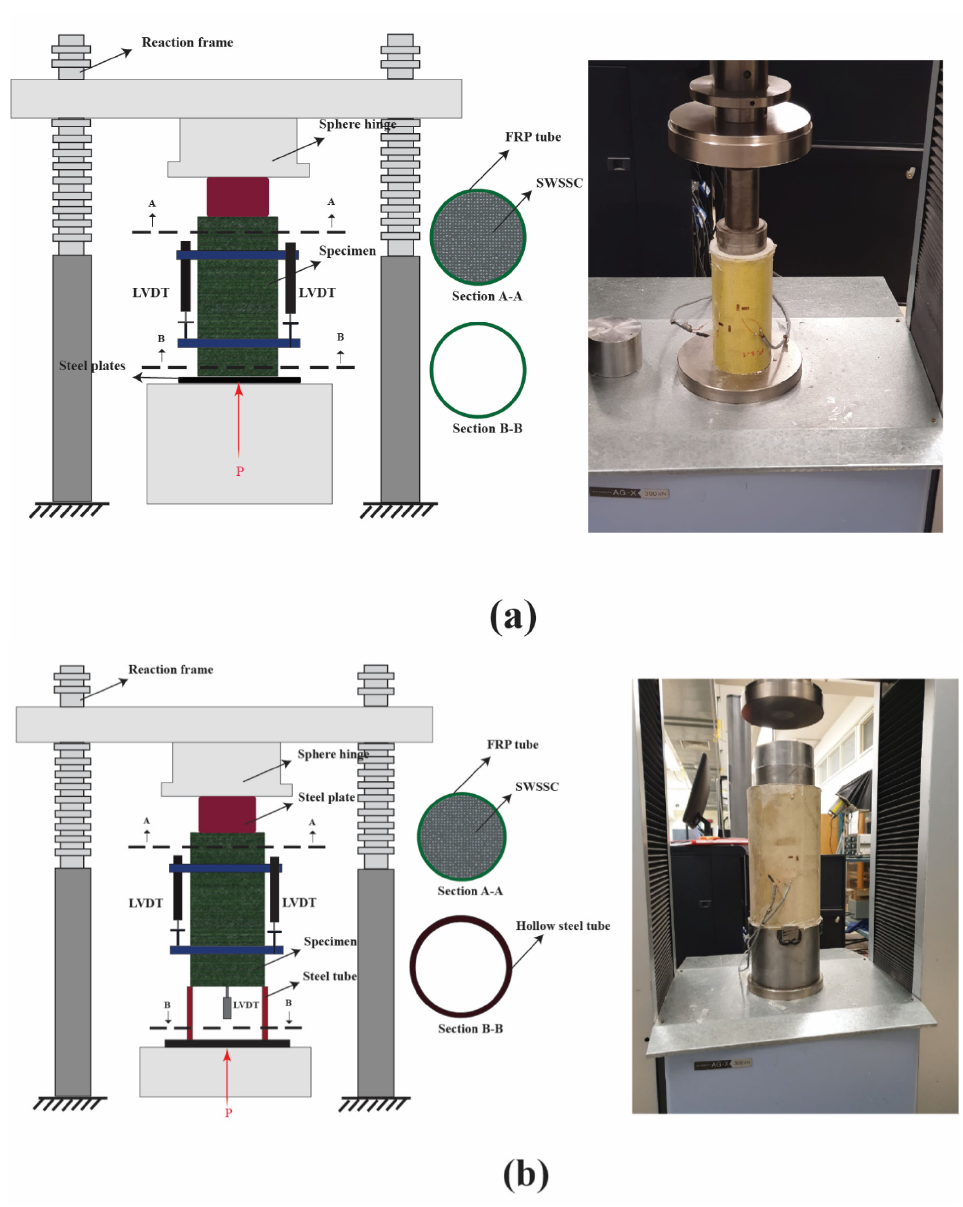
Figure 3. Typical pushout test setup: ( a ) Type a and ( b ) Type b. Reproduced from [22], with permission from Elsevier, 2022.